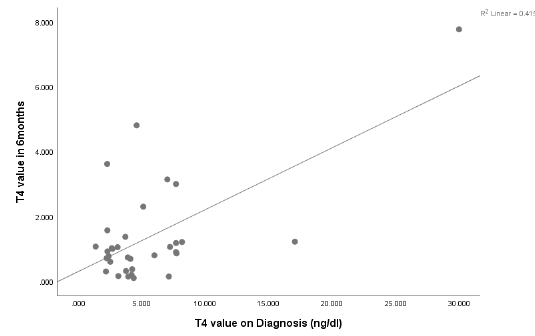
Figure 3: The Scatter plot showing the relationship between the FT4 value on diagnosis and the FT4 value at 06 months after giving the Radioiodine